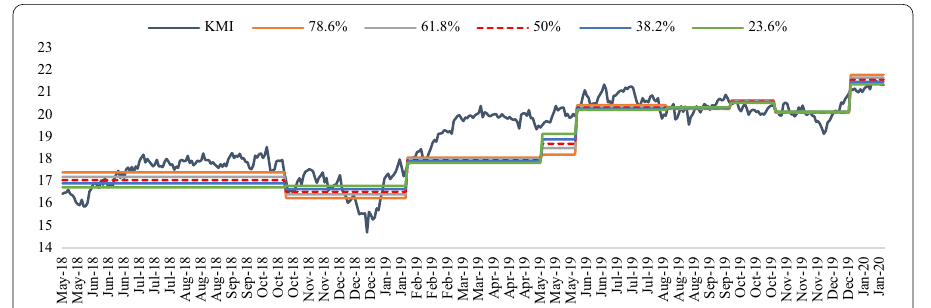
Fig. 7 KMI retracement levels. Note : Fig. 5 reports the daily equity prices, at close, for Kinder Morgan Inc (KMI). The 23.6%, 38.2%, 50%, 61.8%, and 78.6% Fibonacci retracement levels were applied to KMI prices from November 2017 to January 2020. Swing high and swing low prices were taken as the prices at the start of the current and previous trends. Source : Factset and S&P 500 Dow Jones